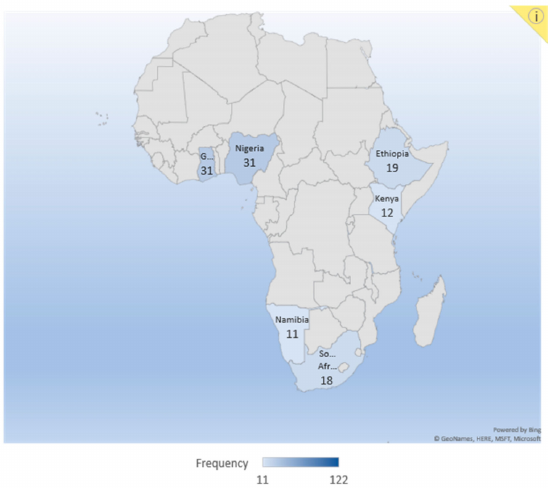
Figure 2. Africa map highlighting the countries